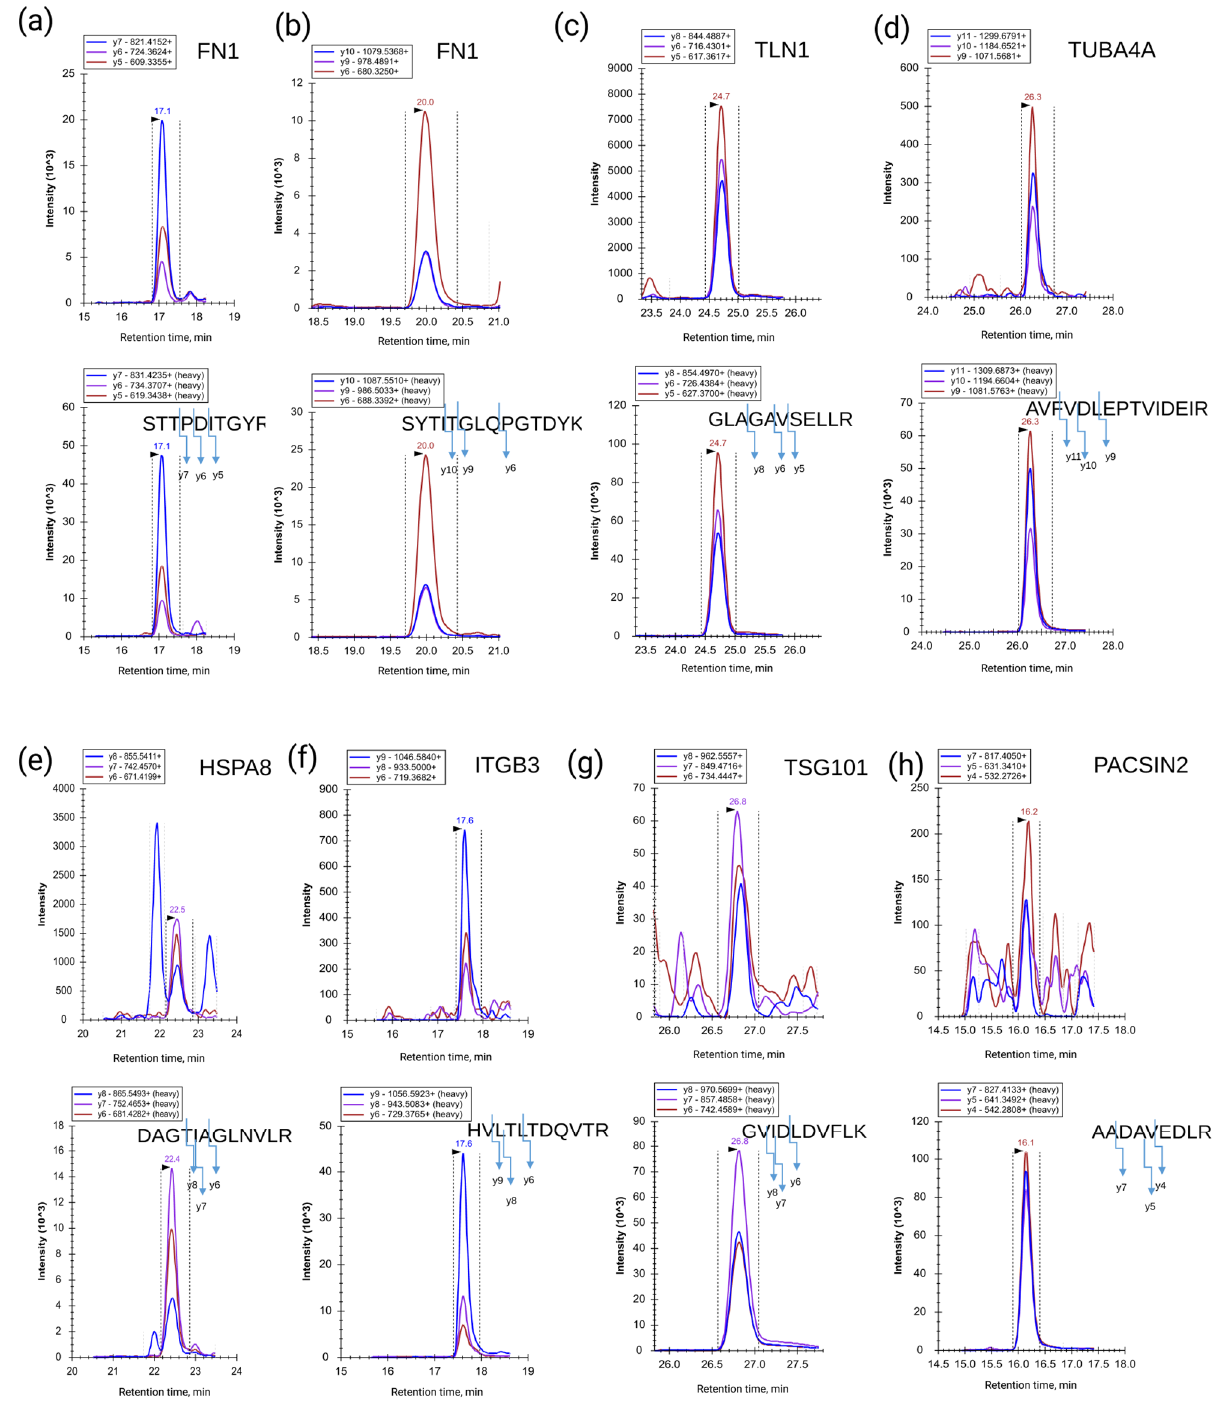
Figure 2. Trace of SRM transitions for native (upper panel) and stable isotope-labeled peptide standards (SISs) (lower panel) detected in blood plasma for EV-associated proteins: ( a , b ) fibronectin (FN1, peptides STTPDITGYR and SYTITGLQPGTDYK); ( c ) talin-1 (TLN1, peptide GLAGAVSELLR); ( d ) tubulin alpha-4A chain (TUBA4A, peptide AVFVDLEPTVIDEIR); ( e ) heat shock cognate 71 kDa protein (HSPA8, peptide DAGTIAGLNVLR); ( f ) integrin beta-3 (ITGB3, peptide HVLTLTDQVTR); ( g ) tumor susceptibility gene 101 protein (TSG101, peptide GVIDLDVFLK); and ( h ) protein kinase C and casein kinase substrate in neurons protein 2 (PACSIN2, peptide AADAVEDLR). These proteins were, together, denominated as an EV proteomic signature.